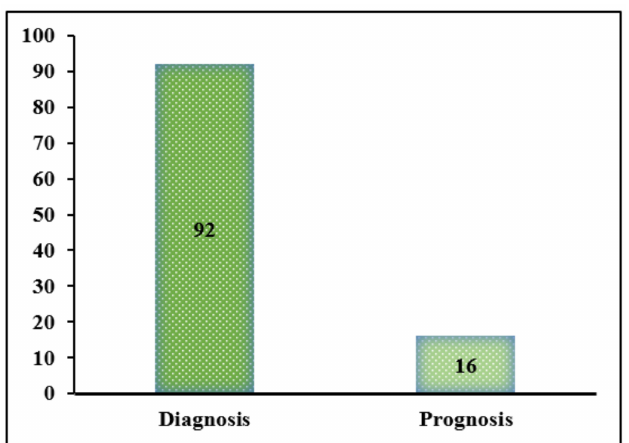
Figure 18. The application of diagnosis and prognosis of pump faults in